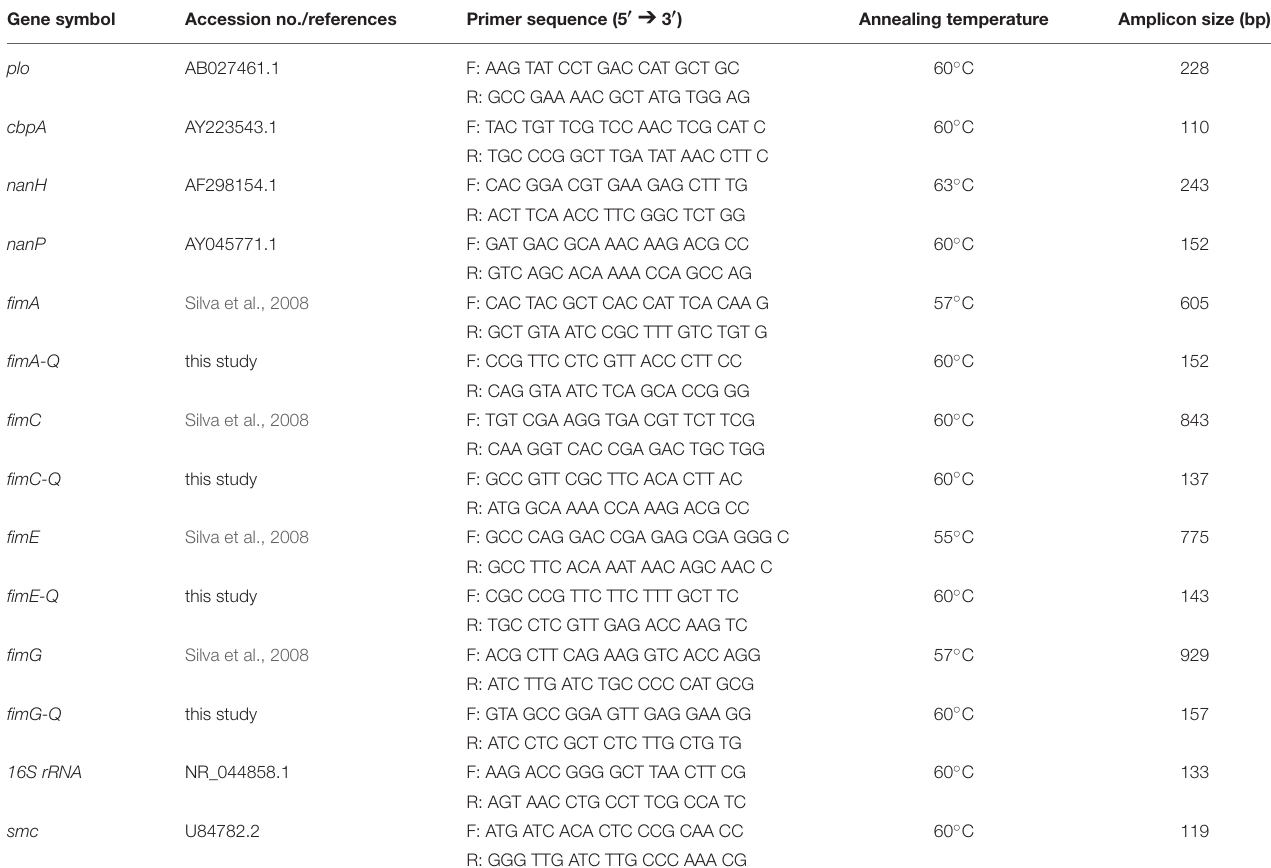
TABLE 1 | Selected known and putative T. pyogenes virulence gene transcripts, primer sequences, and annealing temperatures used for PCR/qPCR with expected amplicon size. Gene